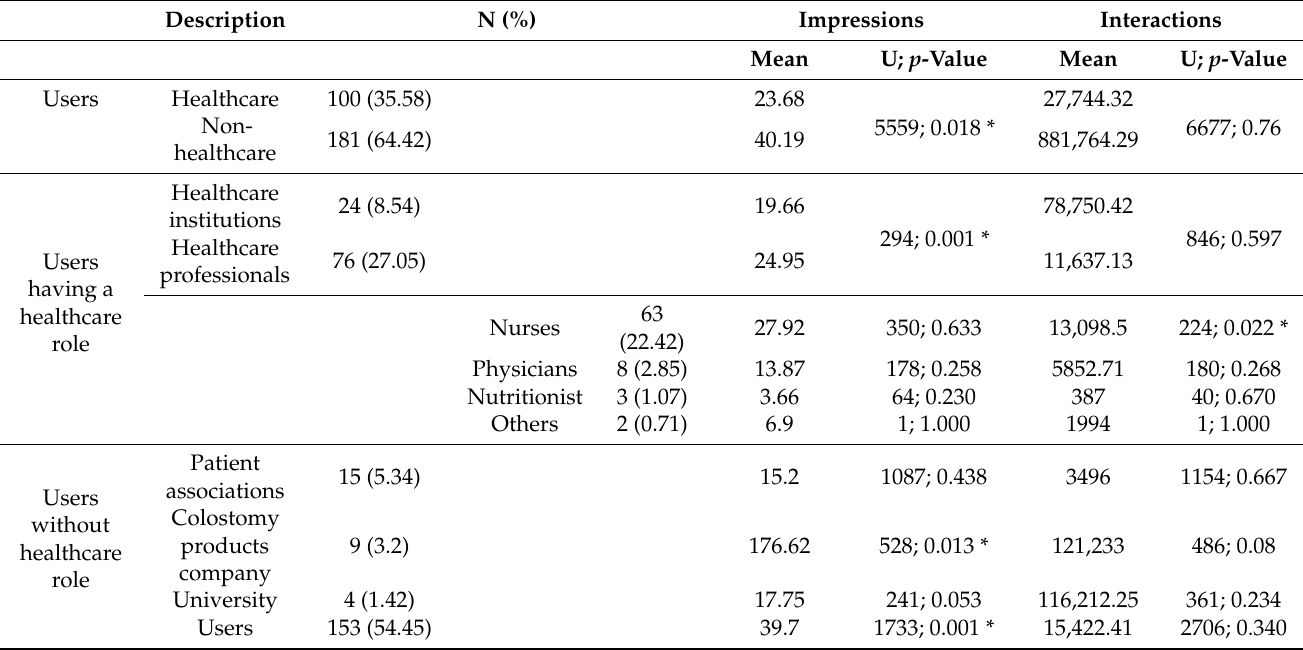
Table 1. Users’ characteristics on colostomy